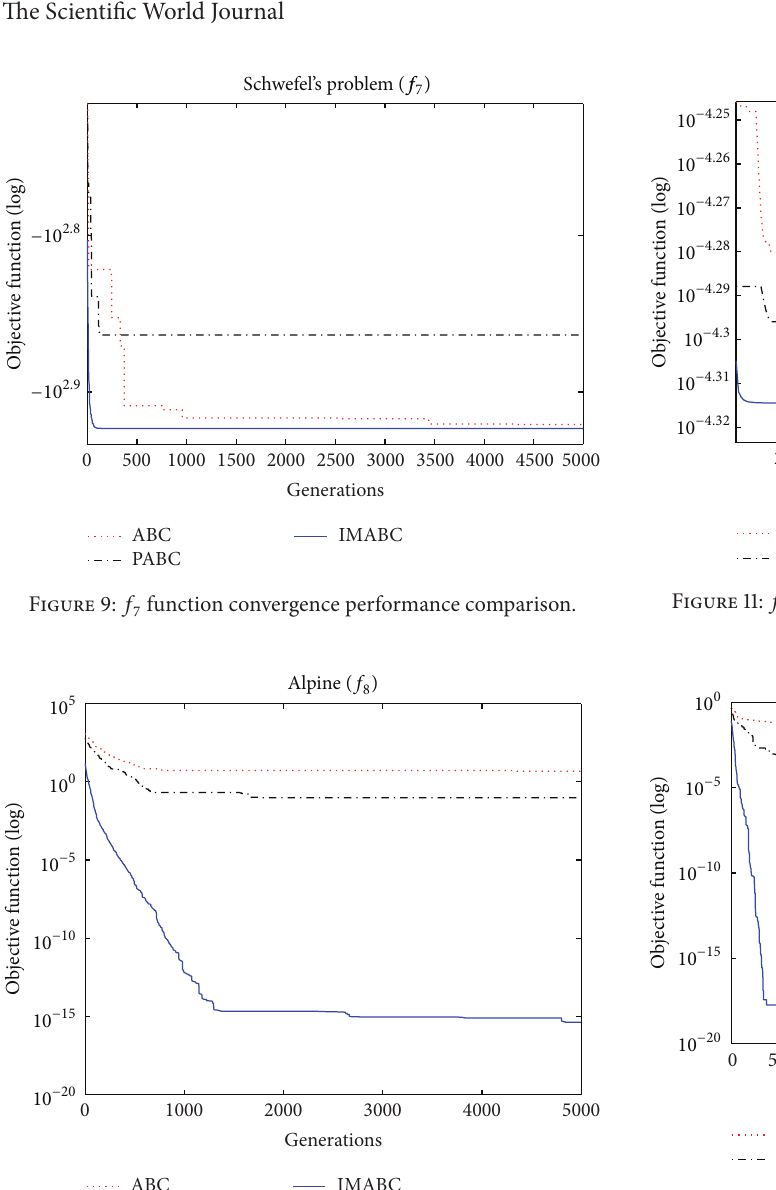
Figure 12: 𝑓 10 function convergence performance